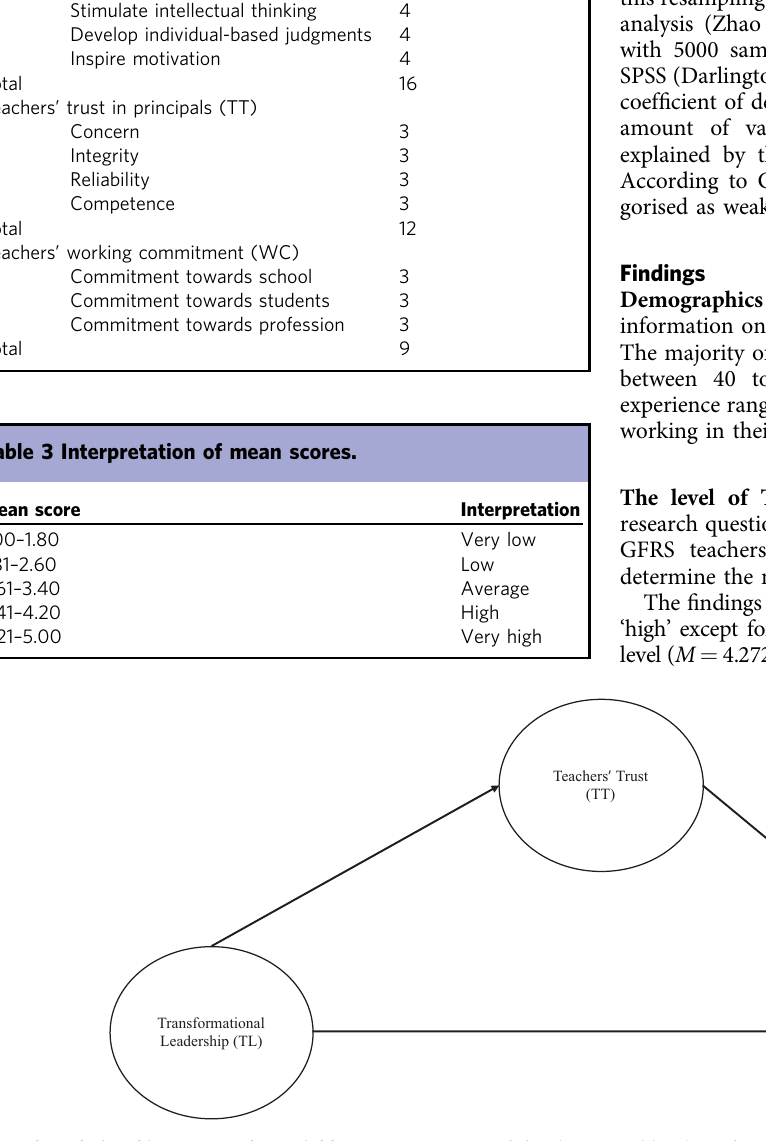
Fig. 1 The relationships among the variables. Representation of the three variables (transformational leadership (tl), teachers ’ trust (tt), and working commitment